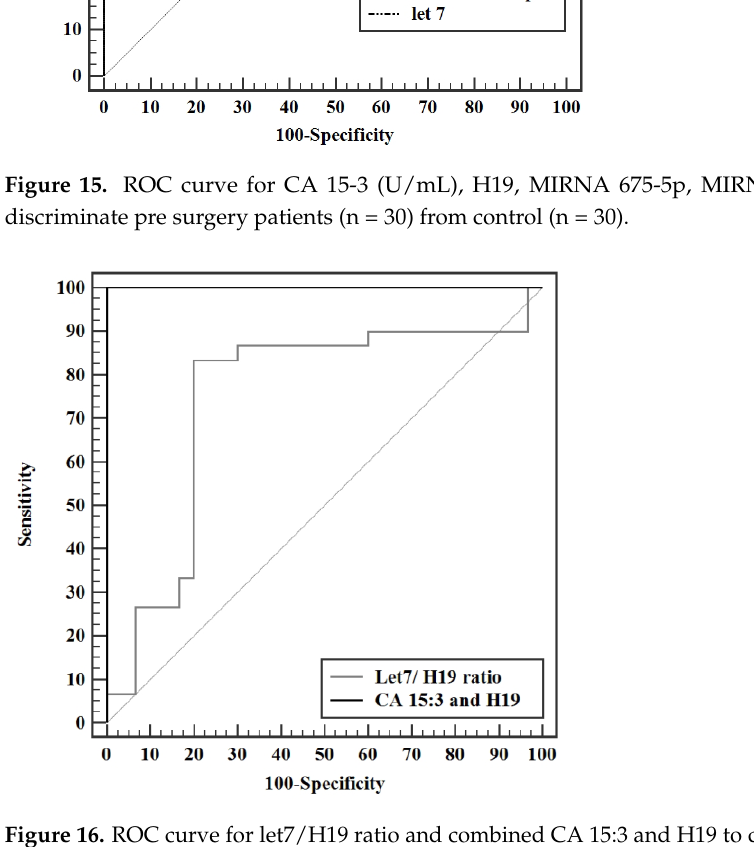
Figure 16. ROC curve for let7/H19 ratio and combined CA 15:3 and H19 to discriminate pre surgery patients (n = 30) from control (n = 30).